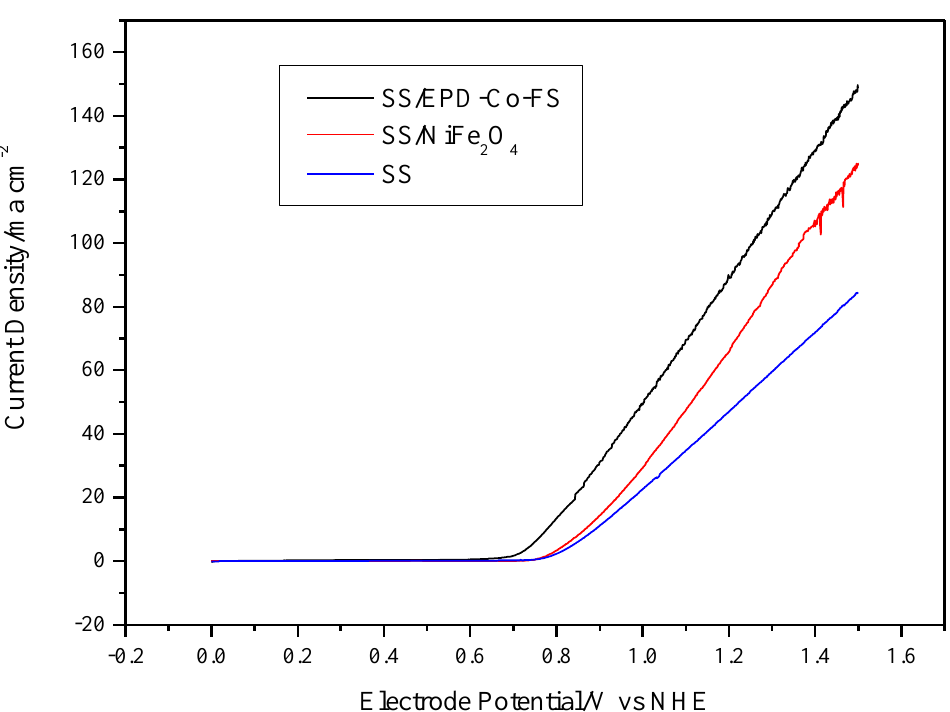
Figure 5. Voltammetries (1 mV s − 1 ) in 0.5 M KOH at 25 ◦ C for SS/EPD-Co 3 O 4 -FS, SS/NiFe 3 O 4 , and SS. The onset potential for O 2 discharge shows the opposite trend, decreasing from about 0.80 V vs. NHE for SS, 0.78 V for SS/NiFe 2 O 4 , down to about 0.71 V for SS/EPD-Co-FS. Considering the thermodynamic potential for the discharge of oxygen in an alkaline environment (0.401 V vs. NHE, for Equation (1)), the electrode potential in